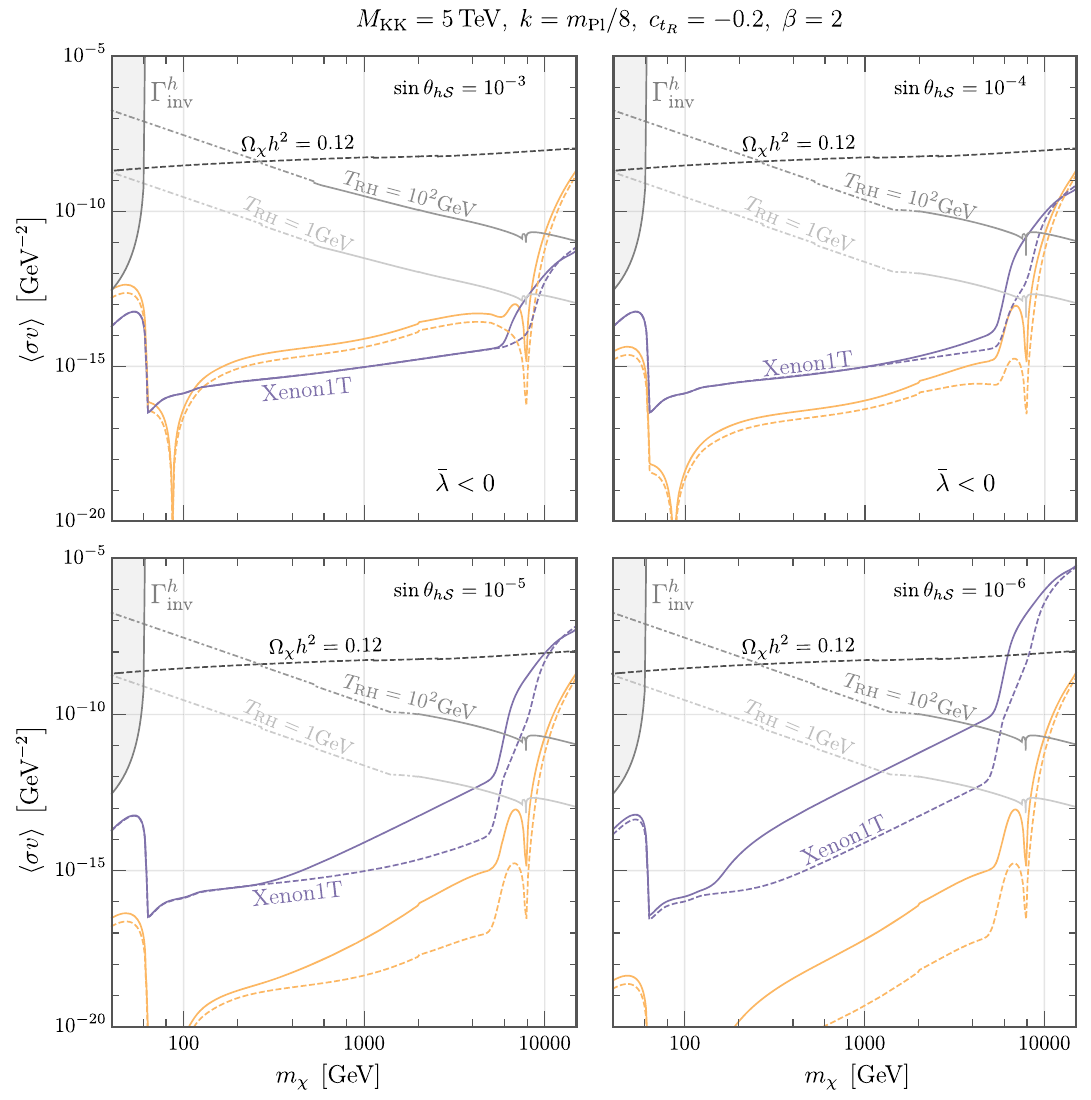
Fig. 9 Velocity averaged coannihilation cross section at the freeze-out in gray and the limits from Xenon1T in purple. We show the velocity temperature for different values of the mixing between the odd scalar averaged cross section reproducing the relic density experimental value and the Higgs boson, sin θ h S = { 10 − 3 , 10 − 4 , 10 − 5 , 10 − 6 } , from top from Planck in dashed black, and the equivalent for a matter domi- nated freeze out in gray, for two different values of T RH , where we used left to bottom right. The first two cases correspond to negative values T (cid:25) = 10 5 GeV and τ = 0 . 99. For these lines the section in dot-dashed of ¯ λ . We have set N χ = 1, M KK = 5 TeV and k = m Pl / 8. We show in yellow the predictions for two different benchmarks with different val- gray corresponds to predictions for which x f < 3, and therefore in this = − 0 . 2 and β = 2. ues of y ∗ and λ S / r . In both cases, we have fixed c t regime the DM decouples relativistically [19,20] R We show the constraints coming from the Higgs invisible decay width